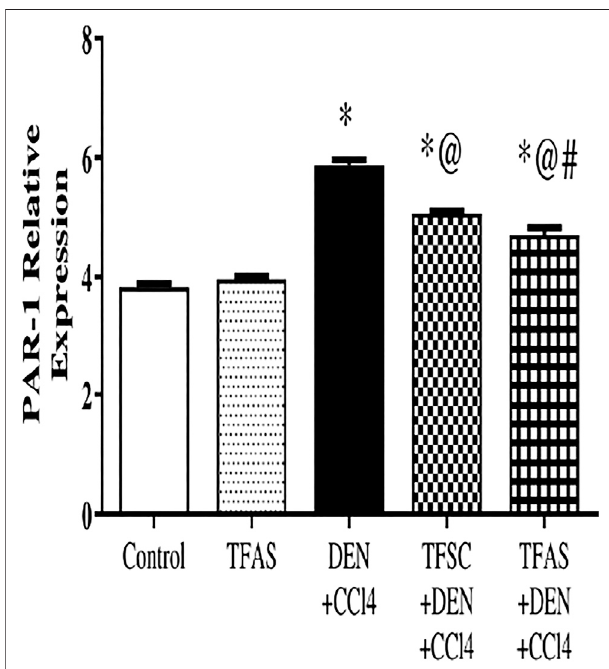
FIGURE 2 | Effect of TF-ODNs on relative expression of PAR1 in liver. Data are expressed as mean ± SEM (n (cid:1) 8). (*), (@) and (#) indicate signi fi cant difference from Control, DEN+CCl4 and TFSC+DEN+CCl4, respectively at P < 0.05 using one-way ANOVA followed by Tukey-Kramer post-Hoc test. PAR1: protease activated receptor 1; DEN: N-diethyl nitrosamine; CCl4: carbon tetrachloride; TFSC: scrambled tissue factor oligodeoxynucleotides; TFAS: antisense tissue factor